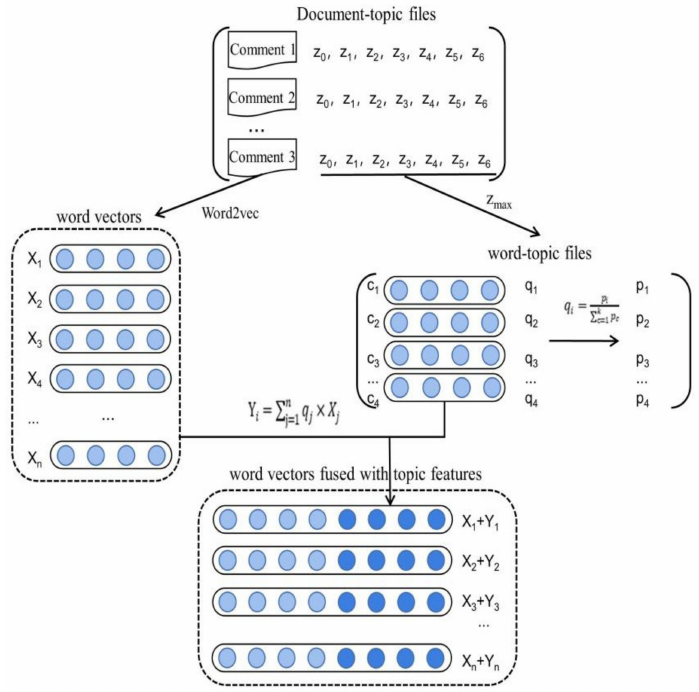
Figure 2. Flow chart of topic feature